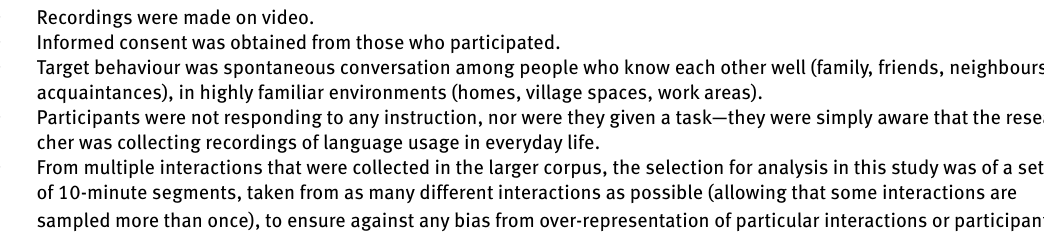
Table 1: Key properties of the data collected for this